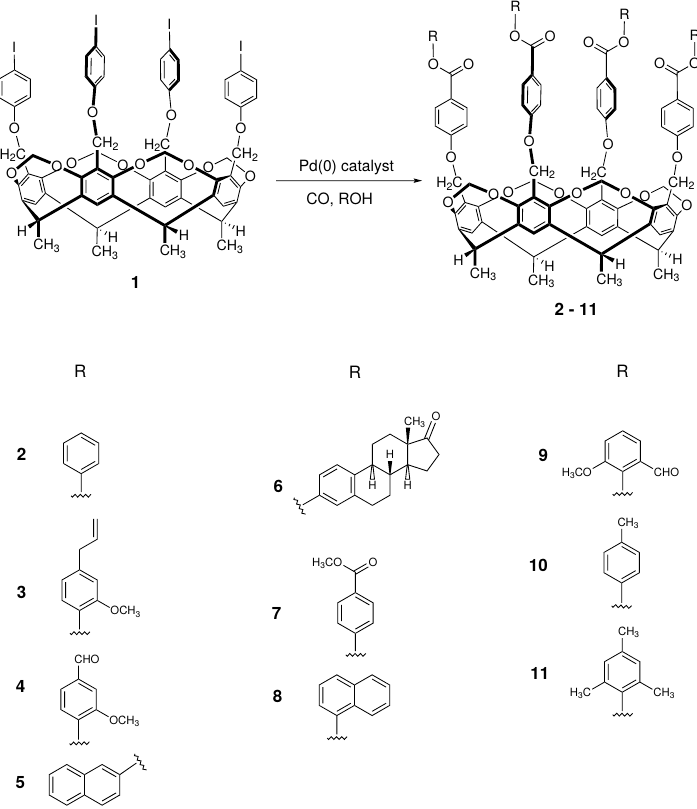
Figure 2. Scheme of aryloxycarbonylation reaction on the cavitand scaffold. Table 2. The achieved chemoselectivities for different ligands and nucleophiles at atmospheric pressure and 100